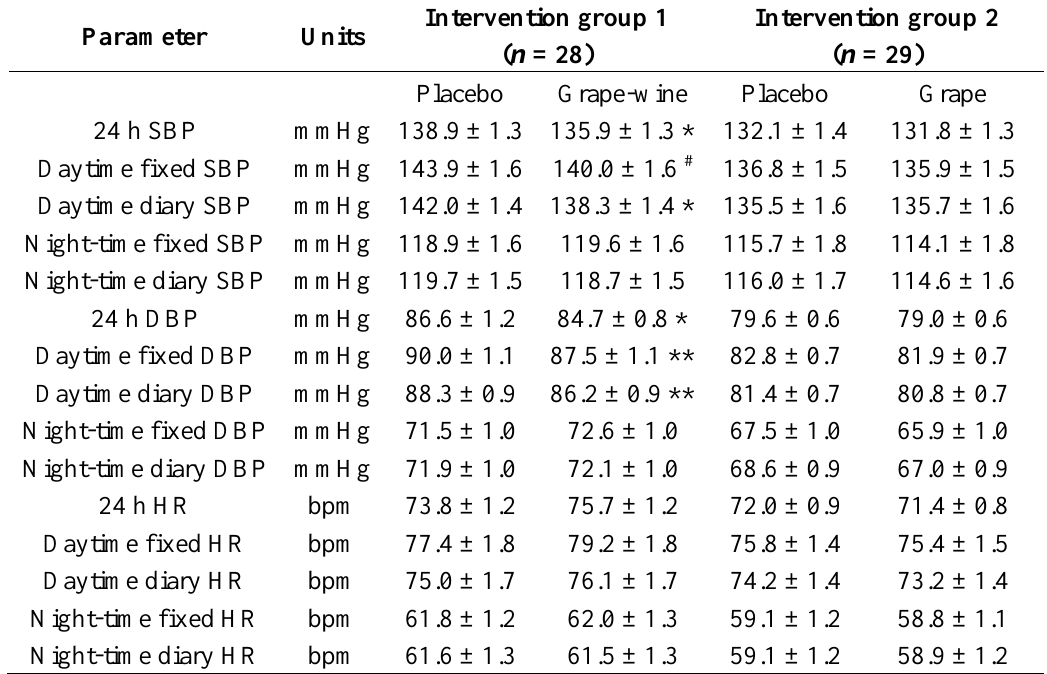
Table 1. The effect of grape-wine extract and grape extract on BP and heart rate (HR) parameters.